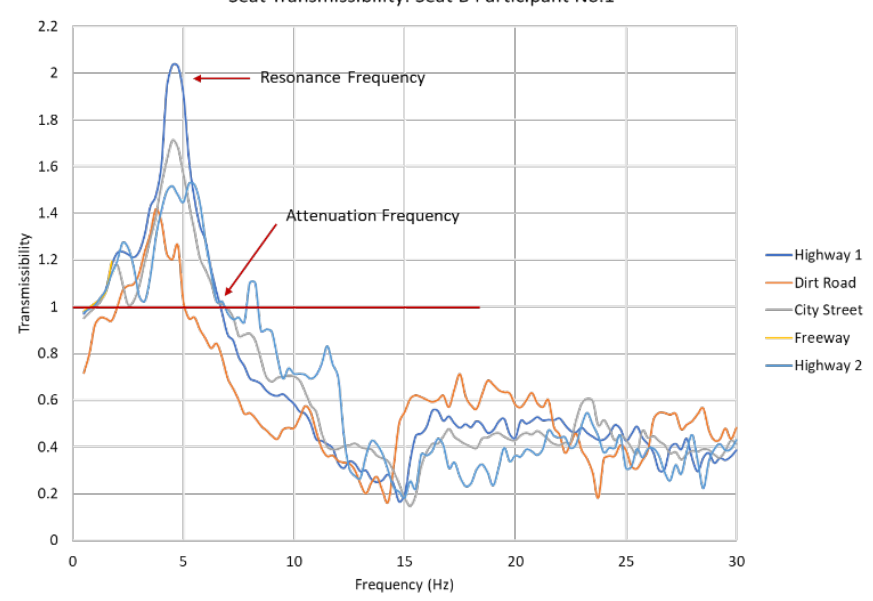
Figure 5. Example of vibration transmissibility plot and the definition of resonance frequency and attenuation frequency in this study.